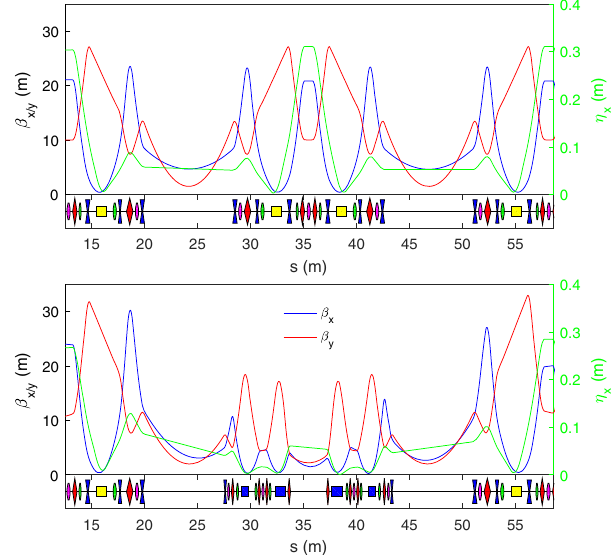
FIG. 1. Plot of optics functions and layout before (top) and after (bottom) installation.